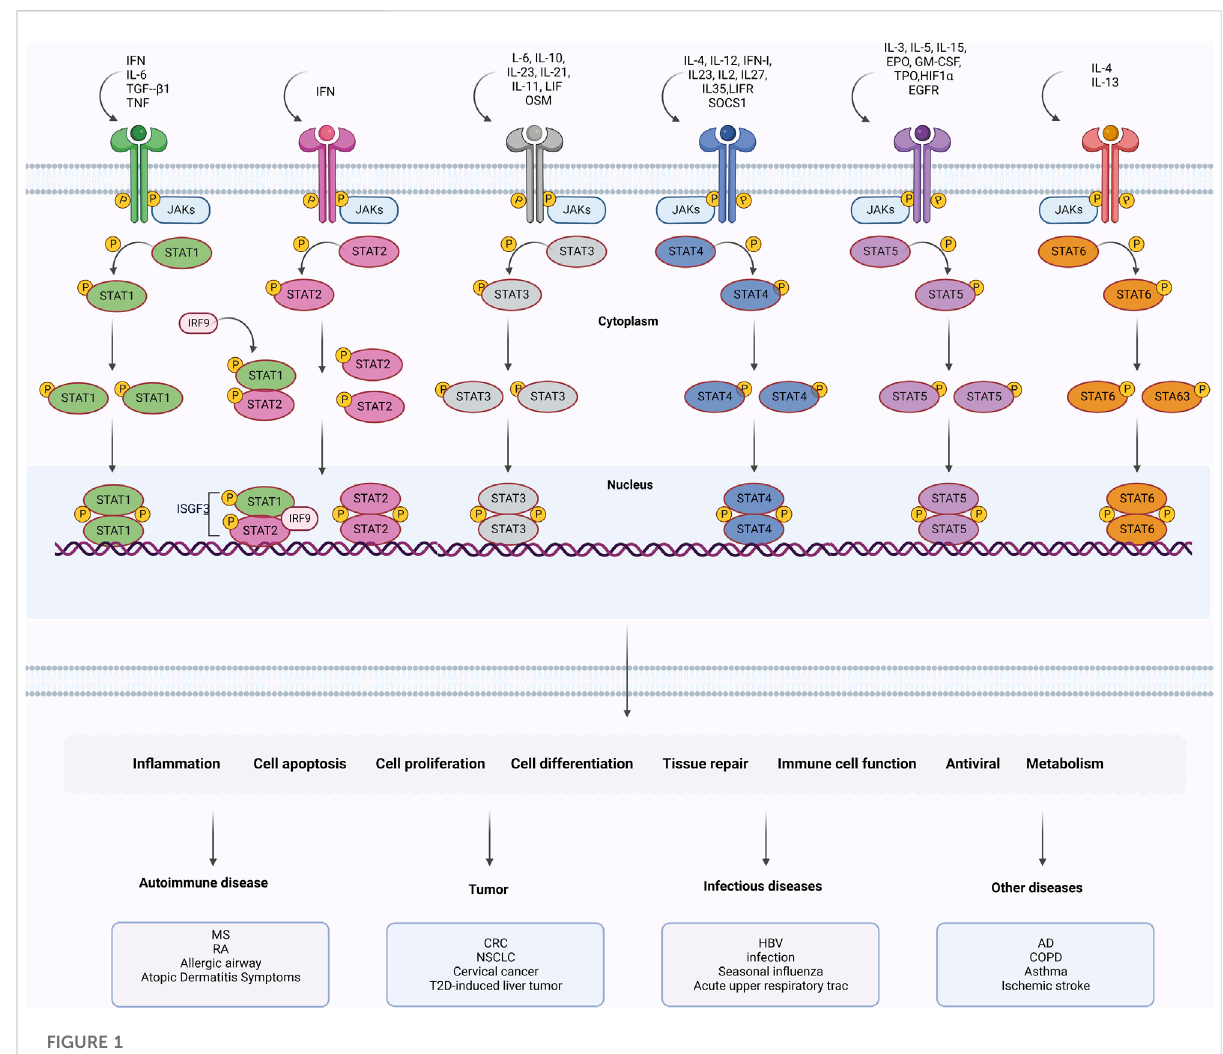
FIGURE 1 Activation of the JAK/STAT signaling pathway and involved